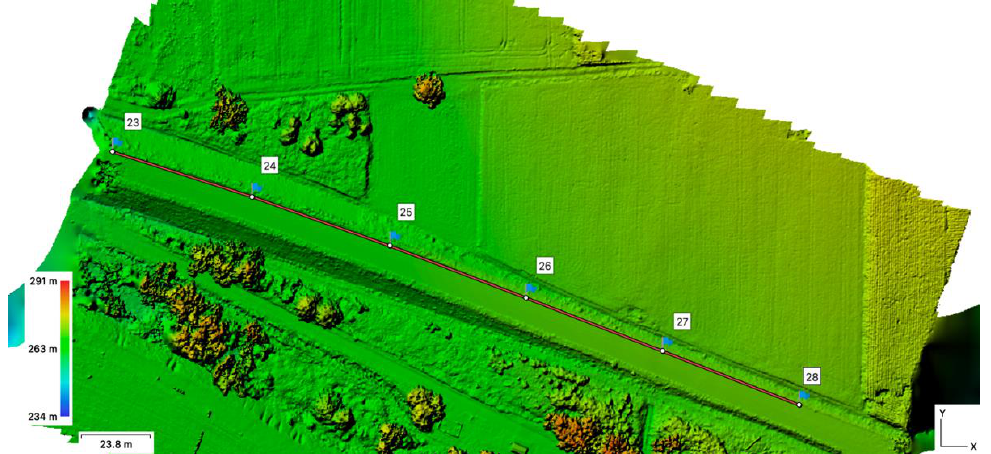
Figure 15. DEM model with a defined course of the longitudinal profile.